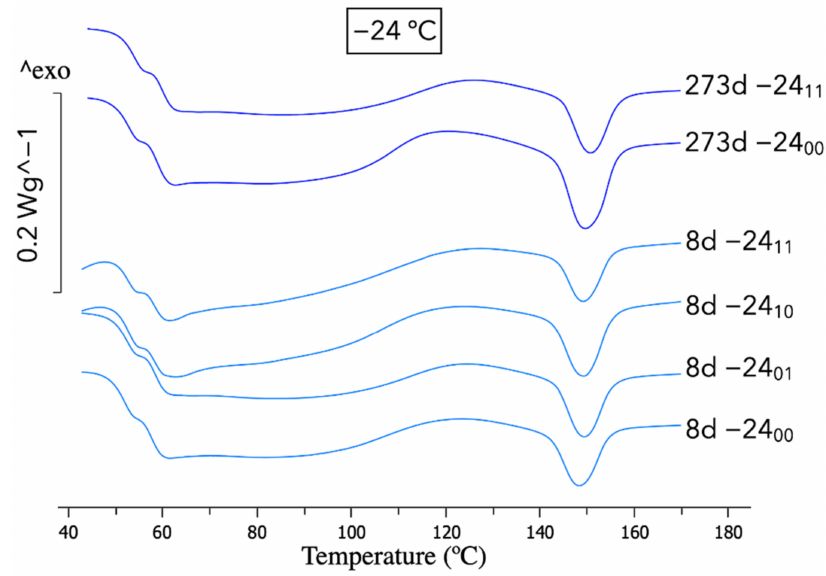
Figure 5. DSC graphs for samples aged at − 24 ◦ C following the nomenclature in Table